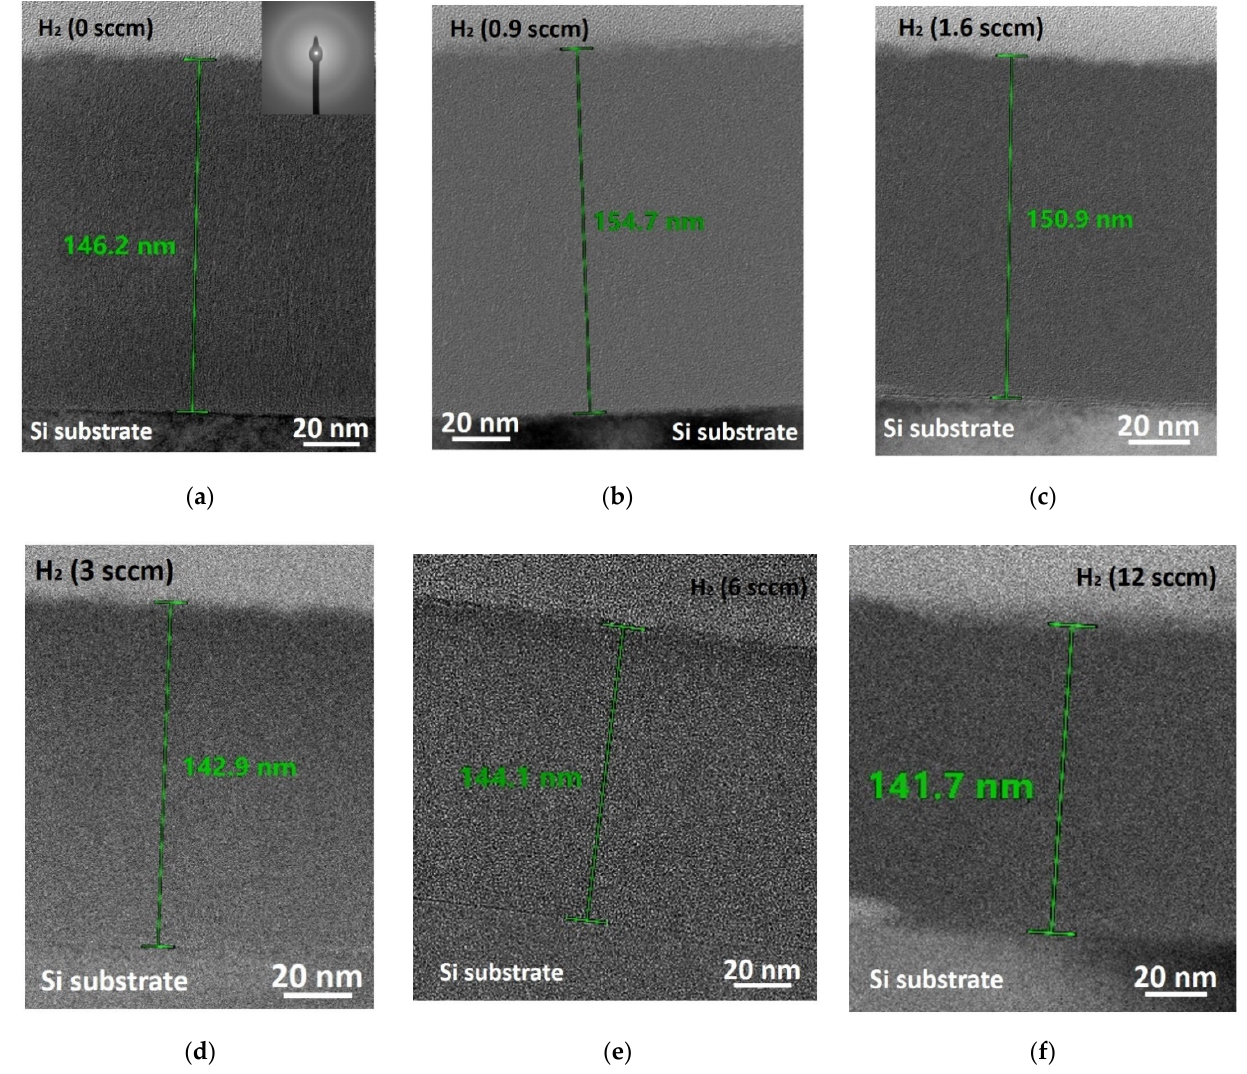
Figure 6. Cross-section TEM images of a-SiN and a-SiN x :H thin films sputtered at different H 2 flow: ( a ) 0 sccm (R1) with selected area electron diffraction (SAED) detail, ( b ) 0.9 sccm (S1), ( c ) 1.6 sccm (S2), ( d ) 3 sccm (S3), ( e ) 6 sccm (S4), and ( f )12 sccm (S5).